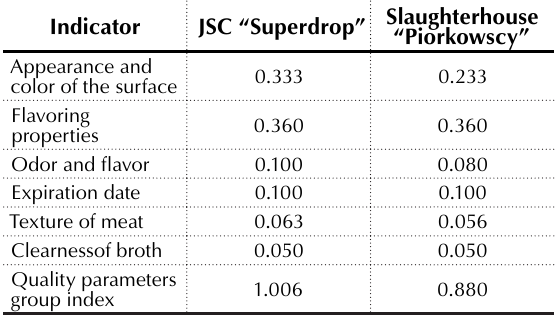
Table 1. Calculation of the quality parameters